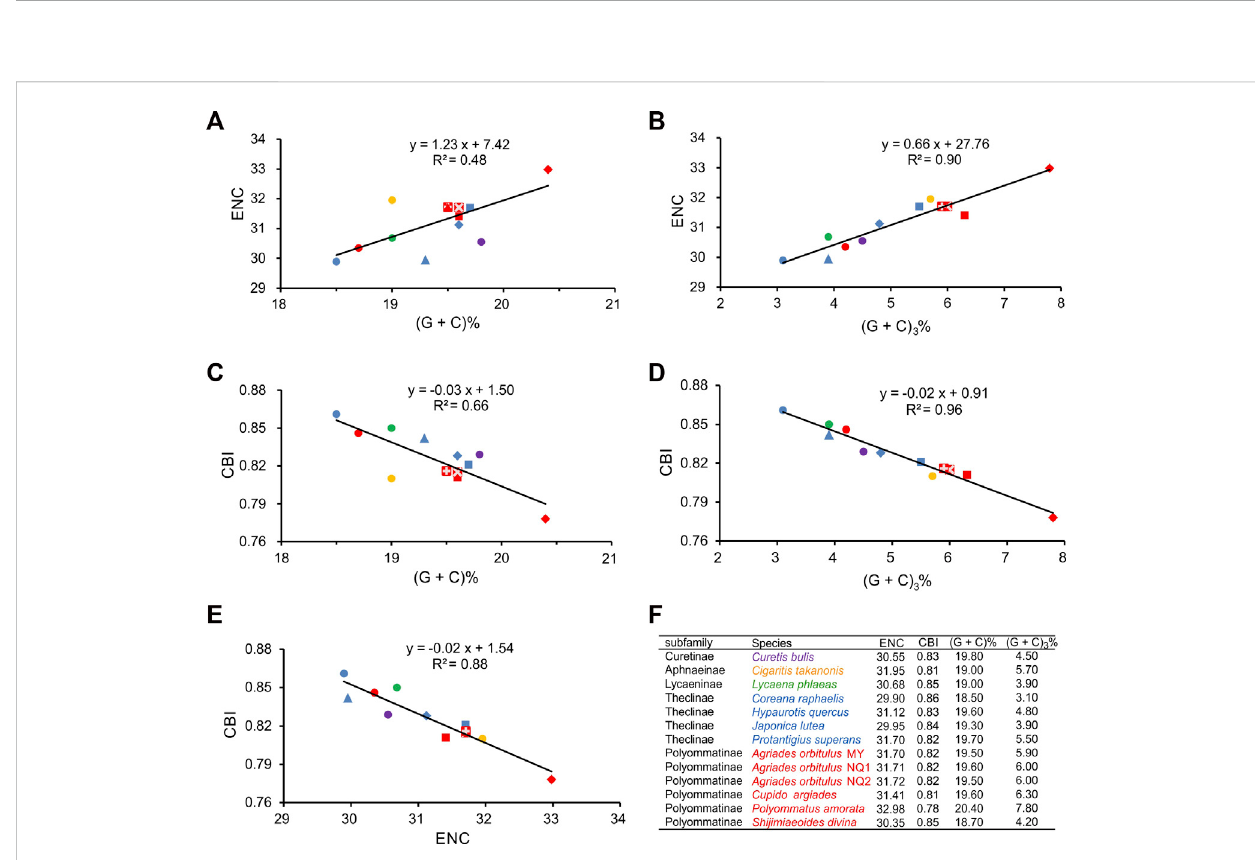
FIGURE 5 Evaluation of codon bias in the 13 Lycaenidae mitogenomes. (G + C)%, G + C content at all codon positions in the 13 protein-coding genes (PCGs). (G + C) 3 %, G + C content at the third codon positions in 13 PCGs. ENC, effective number of codons. CBI, codon bias index. The colors of symbols match those in Figure